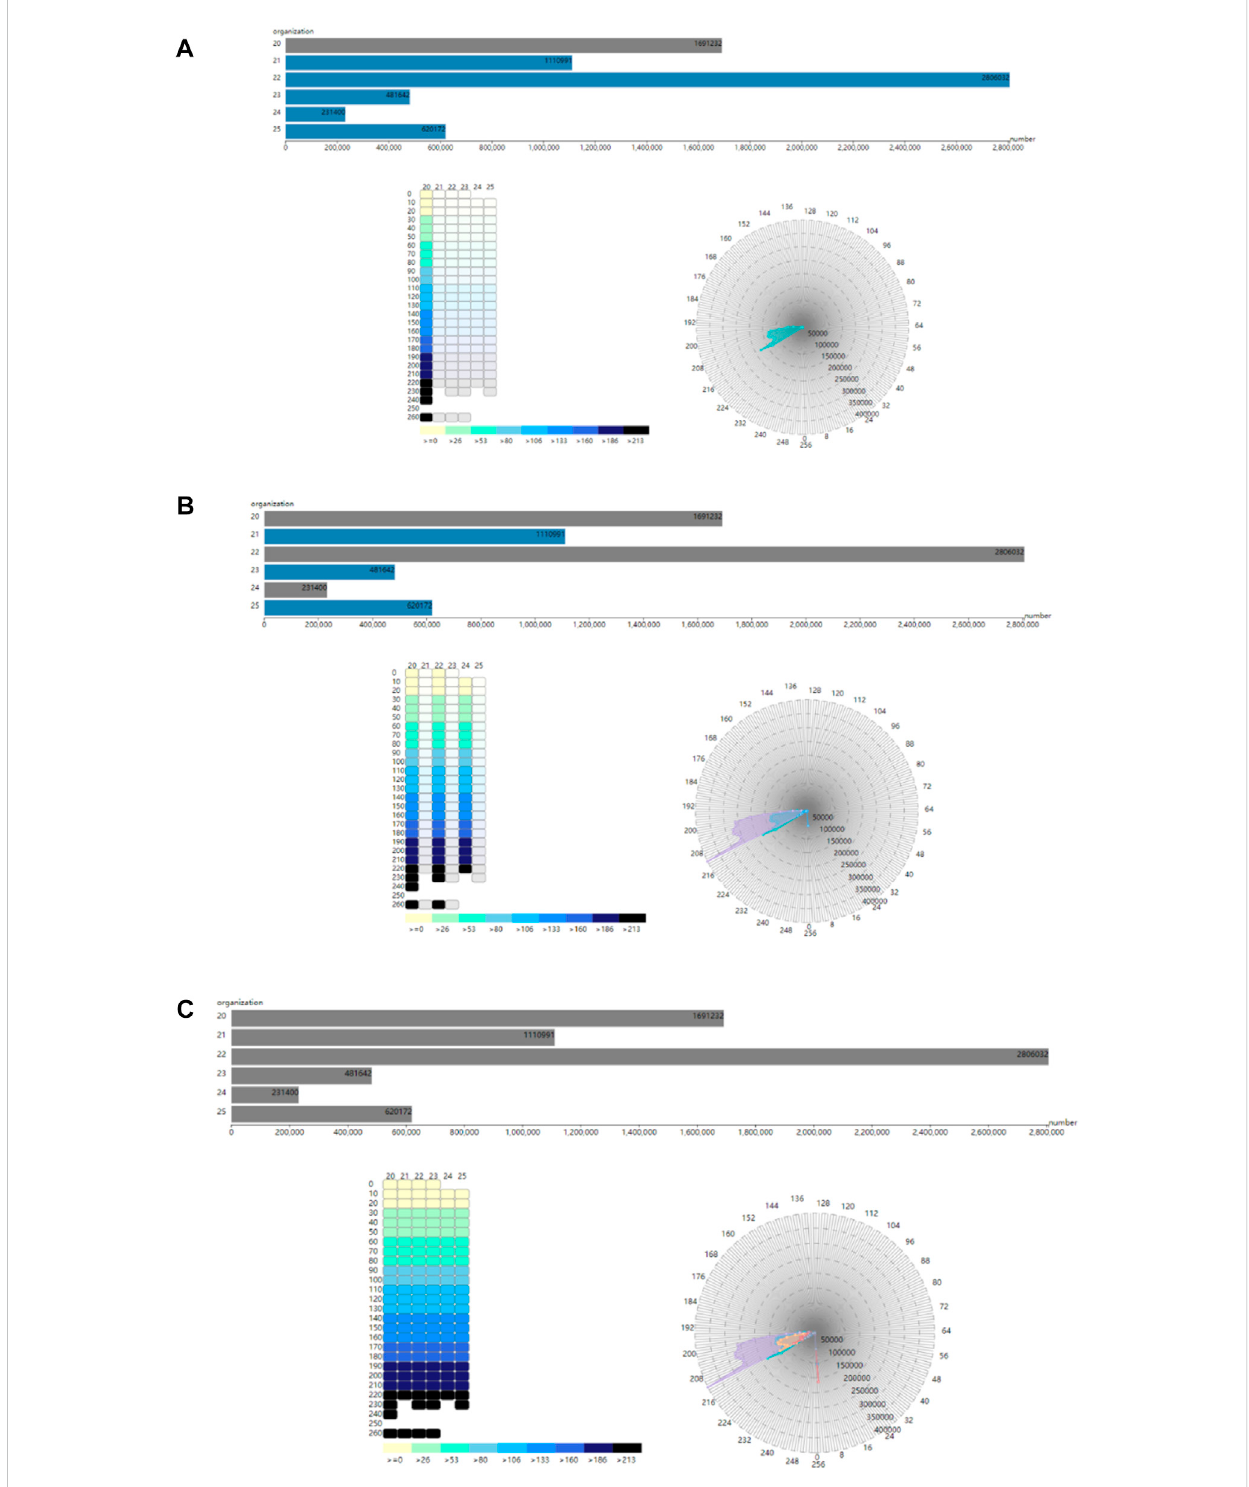
FIGURE 9 The correlation of the tissue-myocyte module, tissue-electrophysiology module and electrophysiology-myocyte module (A) . The association between thethreemoduleswhentheselected tissuevalueis20 (B) .Theassociationbetweenthethreemoduleswhentheselected tissue valueis20,22, and 24. (C) The association between the three modules when the selected tissue value is 20, 21, 22, 23, 24, and